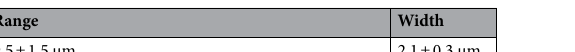
Table 3. Measured average ranges evaluated for several alpha-particle trajectories for HE alpha